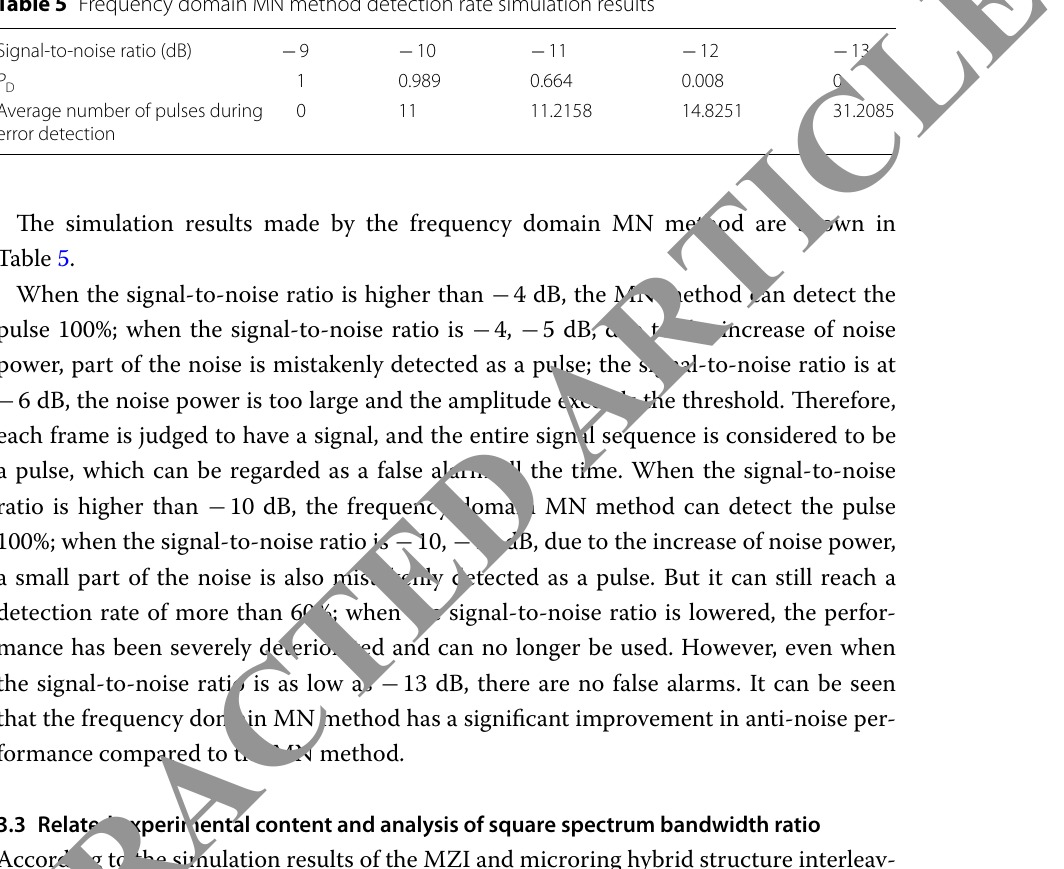
Table 4 MN method detection rate simulation effect Signal-to-noise ratio (dB) Average number of pulses during error detection